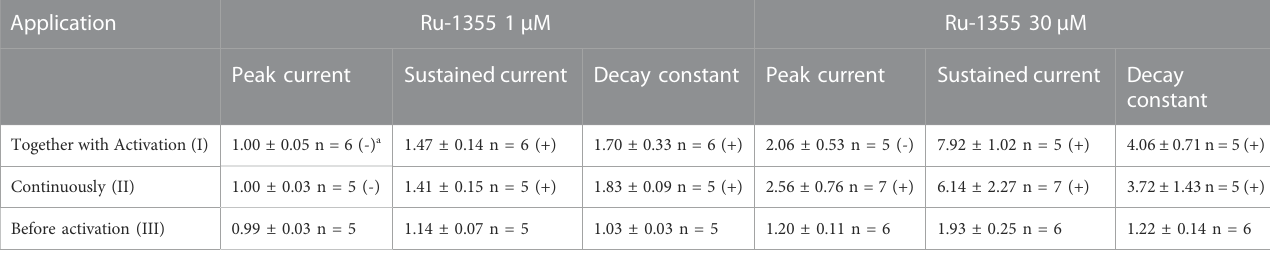
TABLE 2 Effects of Ru-1355 (drug vs. control) on ASIC2a response in different application